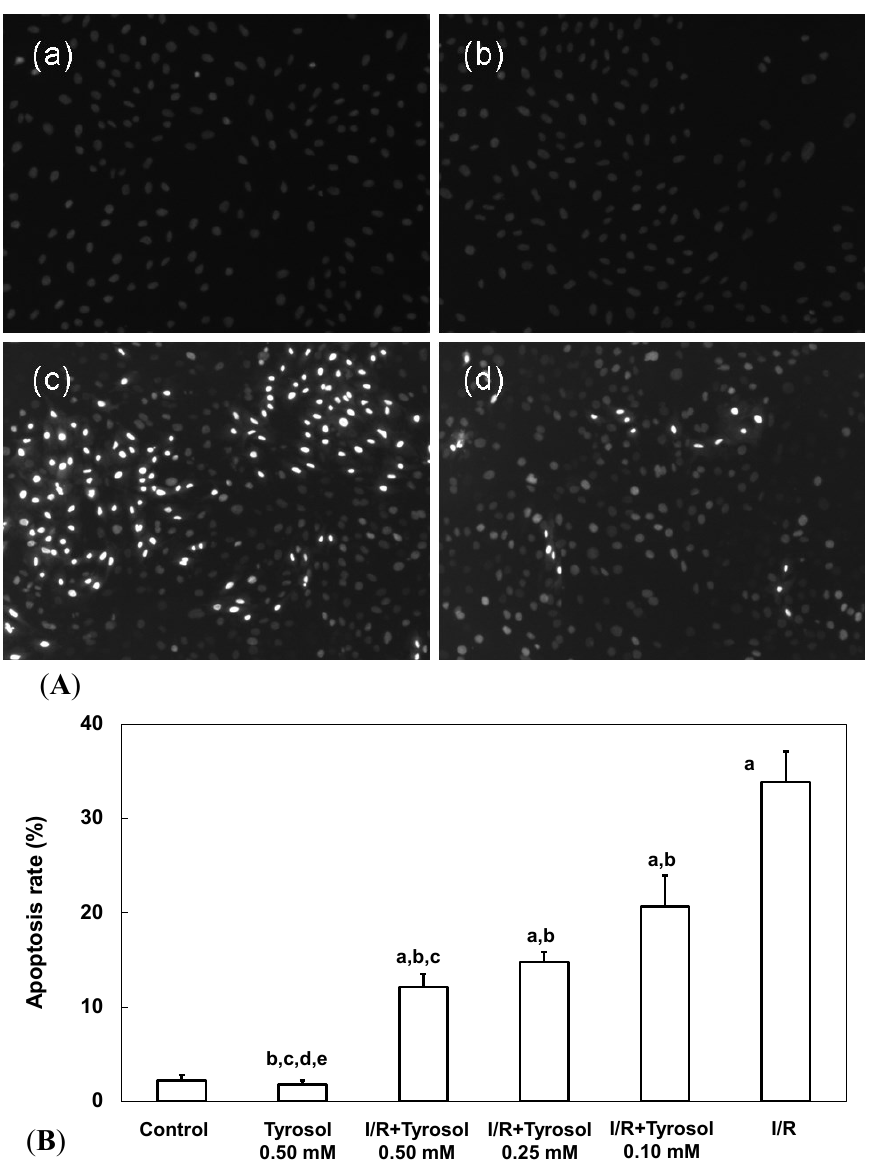
Figure 2. Effect of tyrosol on nuclear condensation in H9c2 cardiomyocytes following I/R. ( A ) Apoptosis associated with nuclear condensation in H9c2 cardiomyocytes. (a) control, (b) tyrosol 0.50 mM, (c) I/R, (d) I/R + tyrosol 0.50 mM. ( B ) Proportions of